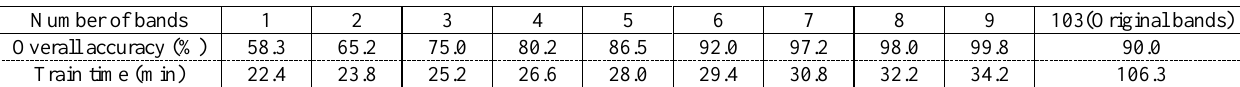
Overall accuracy (%) Table 5. Overall accuracy and training time of the University of Pavia dataset under different number of bands (proposed method)